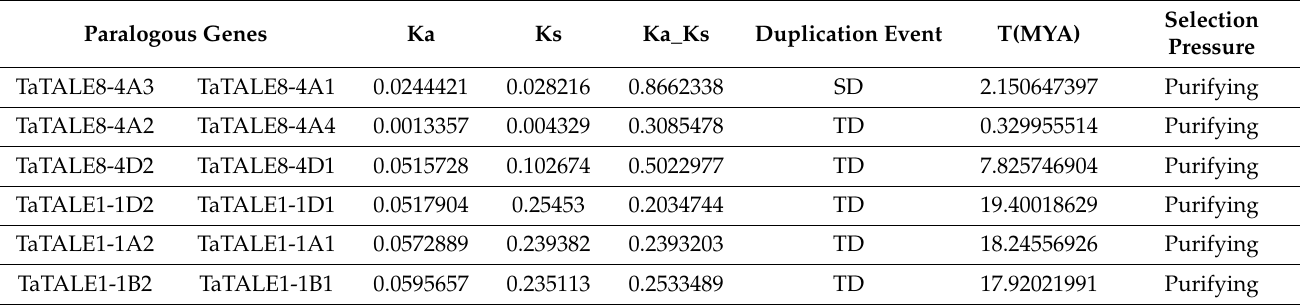
Table 1. The calculation of Ka/Ks ratio and divergence time of duplicated TaTALE gene pairs. Paralogous Genes Ka Ks